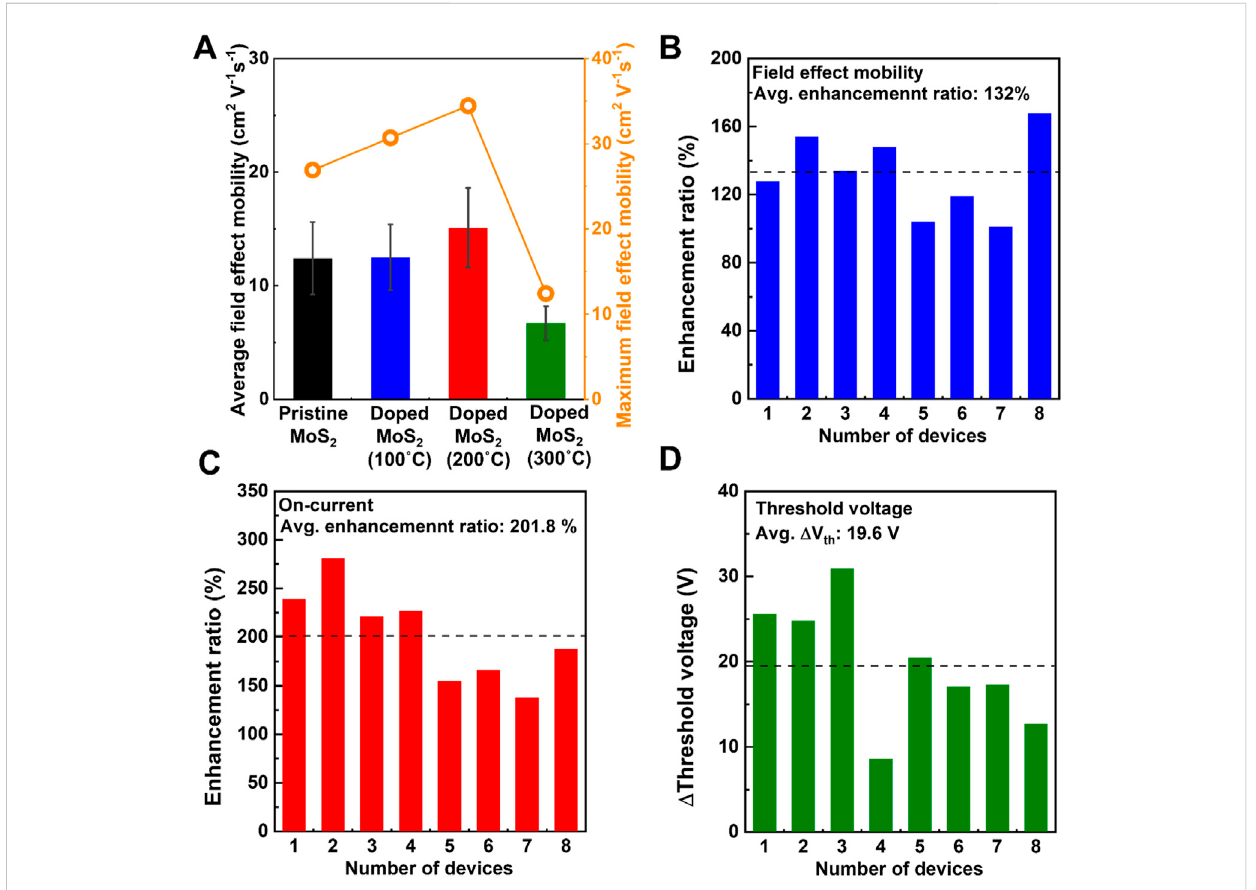
FIGURE 3 Electrical parameters of the pristine MoS 2 FET and the P(VDF-TrFE)-doped MoS 2 FETs (100 200, and 300 ° C) (A) Average and maximum fi eld-effect mobilities. The enhancement ratio of 8 different P(VDF-TrFE)-doped MoS 2 FETs (200 ° C): (B) Field-effect mobility, (C) on-current, and (D) changes in the threshold voltage values compared to pristine